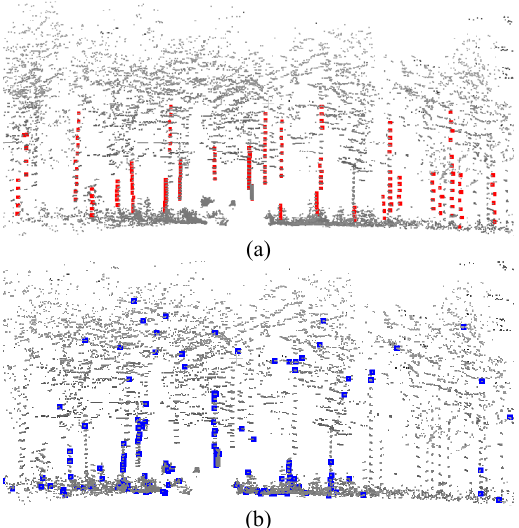
Figure 2. Feature extraction (grey points are the BLS